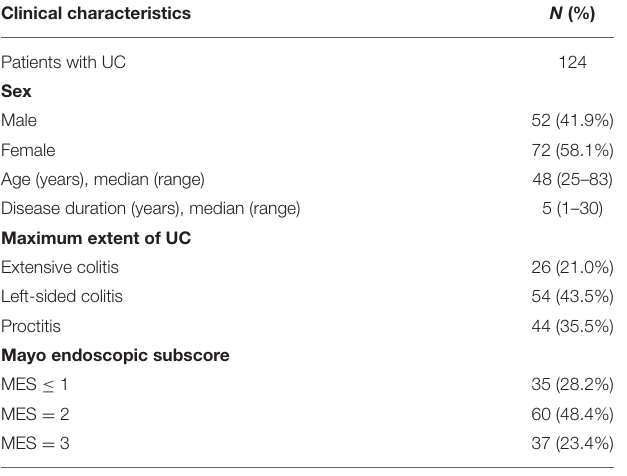
TABLE 4 | Correlation between the degree of inflammation identified by Nancy index (NI) and endoscopy score.